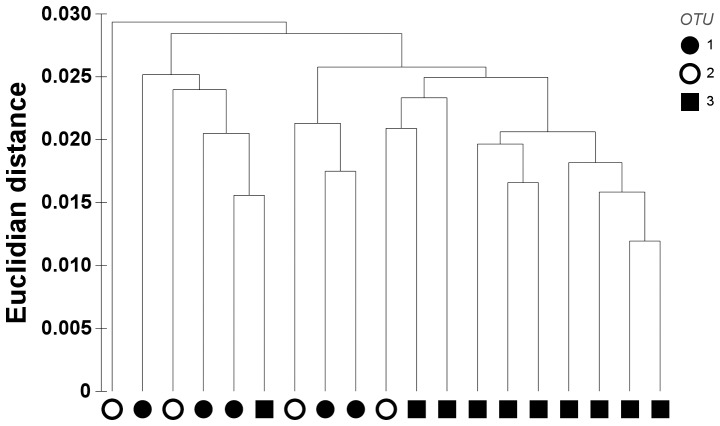
Cluster analysis of a subset of shell outlines (Elliptical Fourier Analysis).Shells analysed are those from group B in Figure 3. The analysis is based on the first 20 harmonics, excluding the first one. Symbols refer to operational taxonomic groups (OTUs) based on CO1, 18S and 28S rRNA sequences.